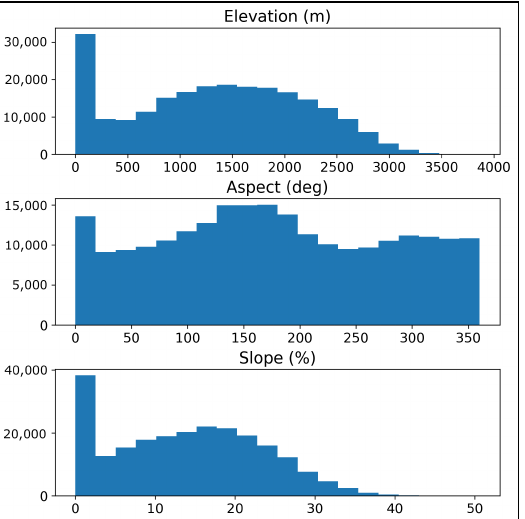
Figure 9. Histograms of the three topographic features, elevation, aspect, and slope (from the top to the bottom). The Y axis of the histogram represents the pixel count for each bin, while the X axis is the value of the elevation in meters, the degree of orientation, and the slope percentage respectively. No data values are